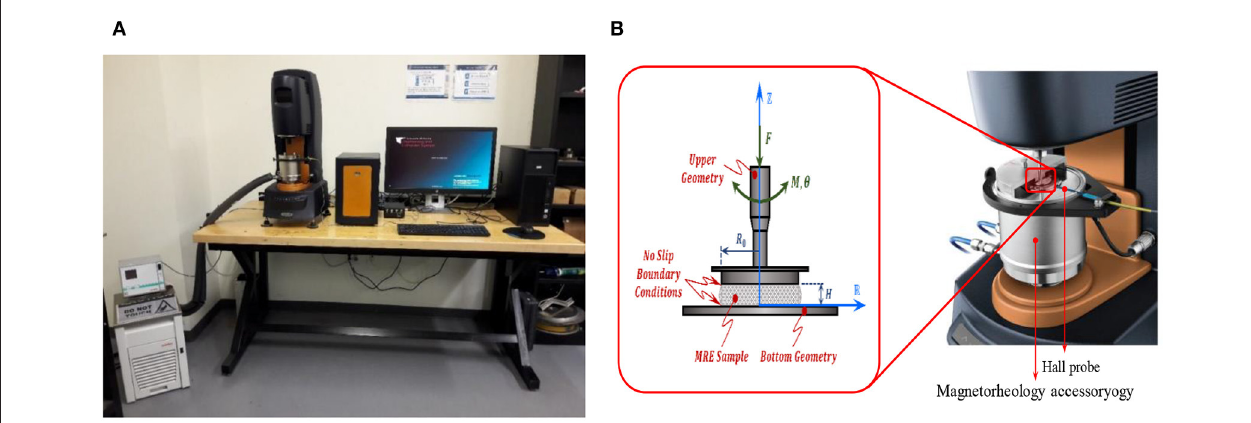
FIGURE 1 | (A) The MRE testing system and (B) schematic diagram of the rotational parallel-plate setup of the rotary rheometer equipped with magnetorheology accessory.